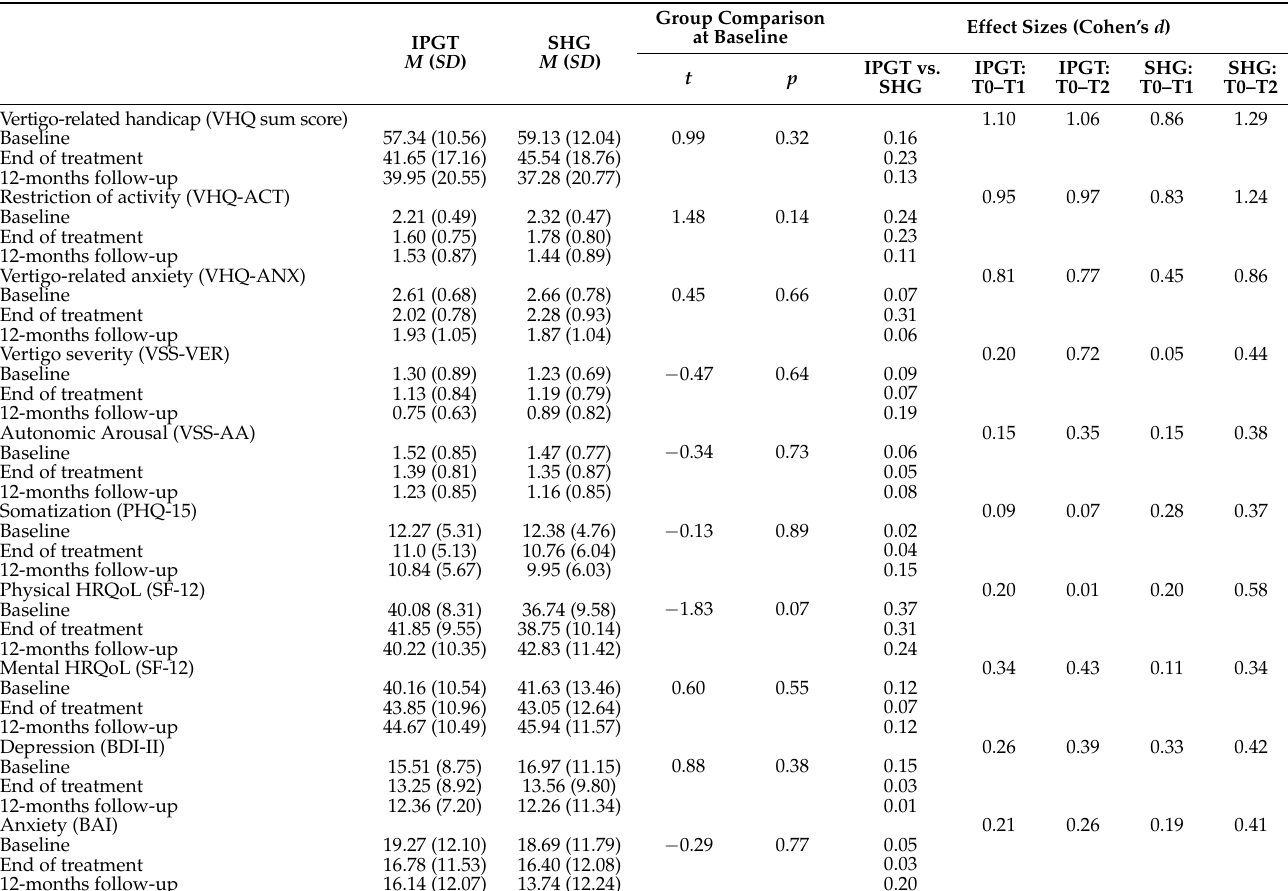
Table 3. Outcome measure scores at baseline, end of treatment, and 12-month follow-up, along with sensitivity analyses comparing the groups at baseline.